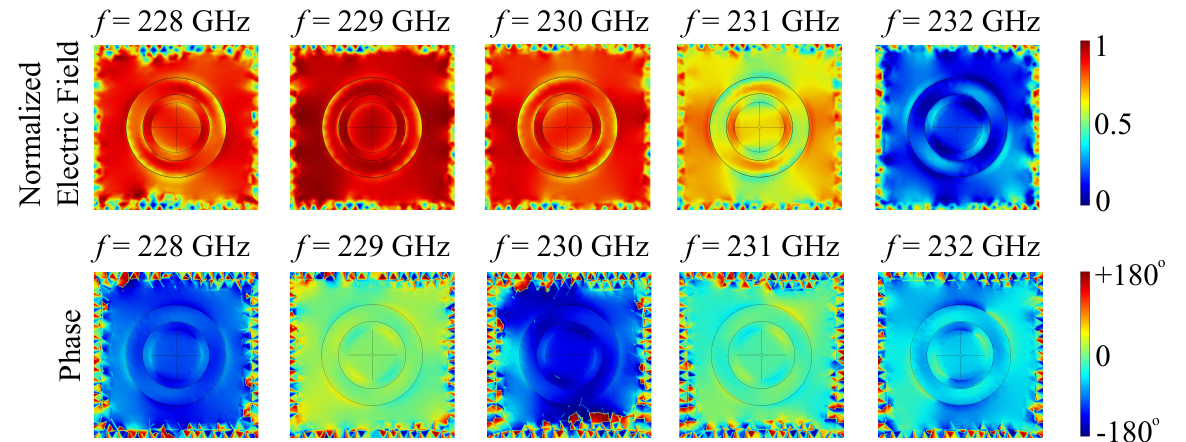
Figure 15. Simulated electric field and in-plane nonlocal phase distributions across the cell element for the silicon substrate